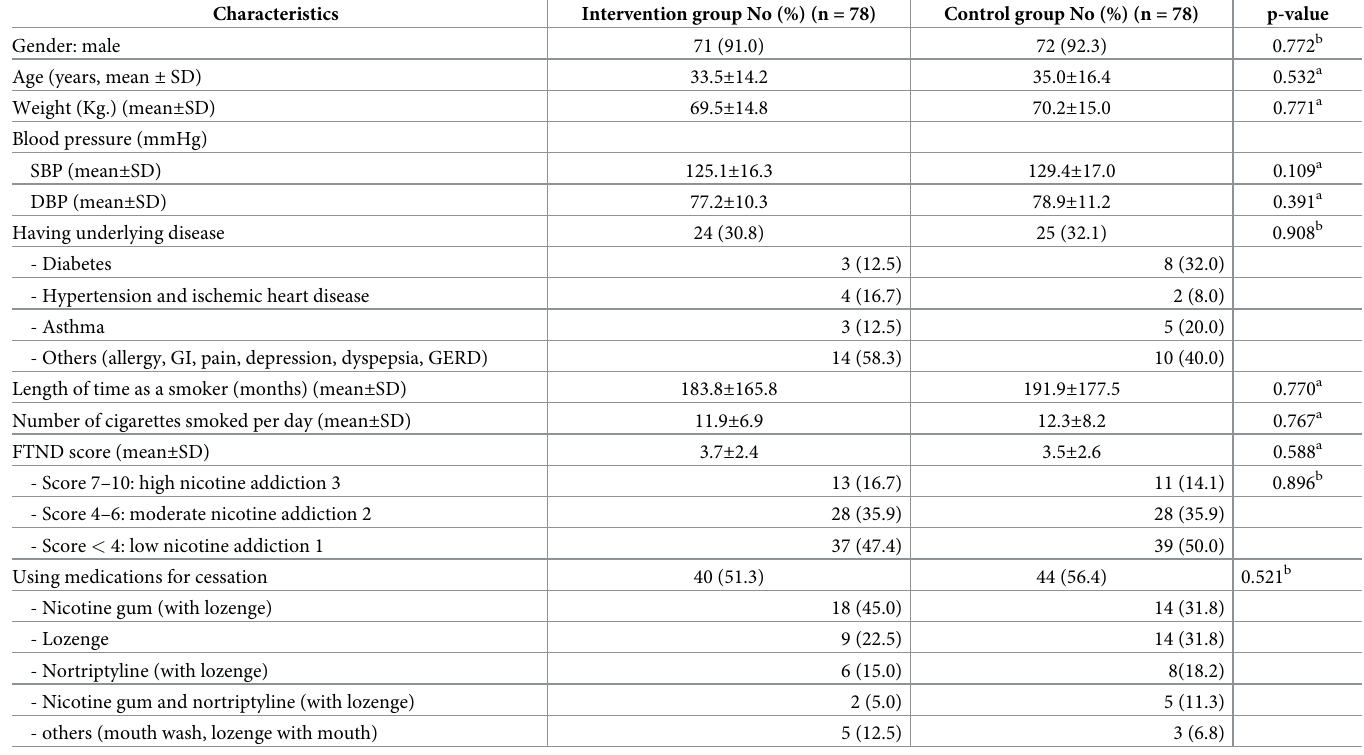
Table 1. Baseline characteristics of participants in the intervention and control groups.